Question: What form of chart is displayed?
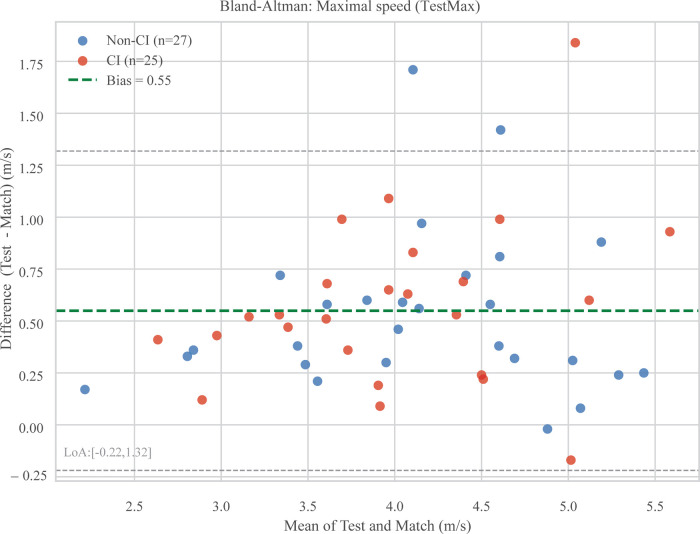
Answer: box